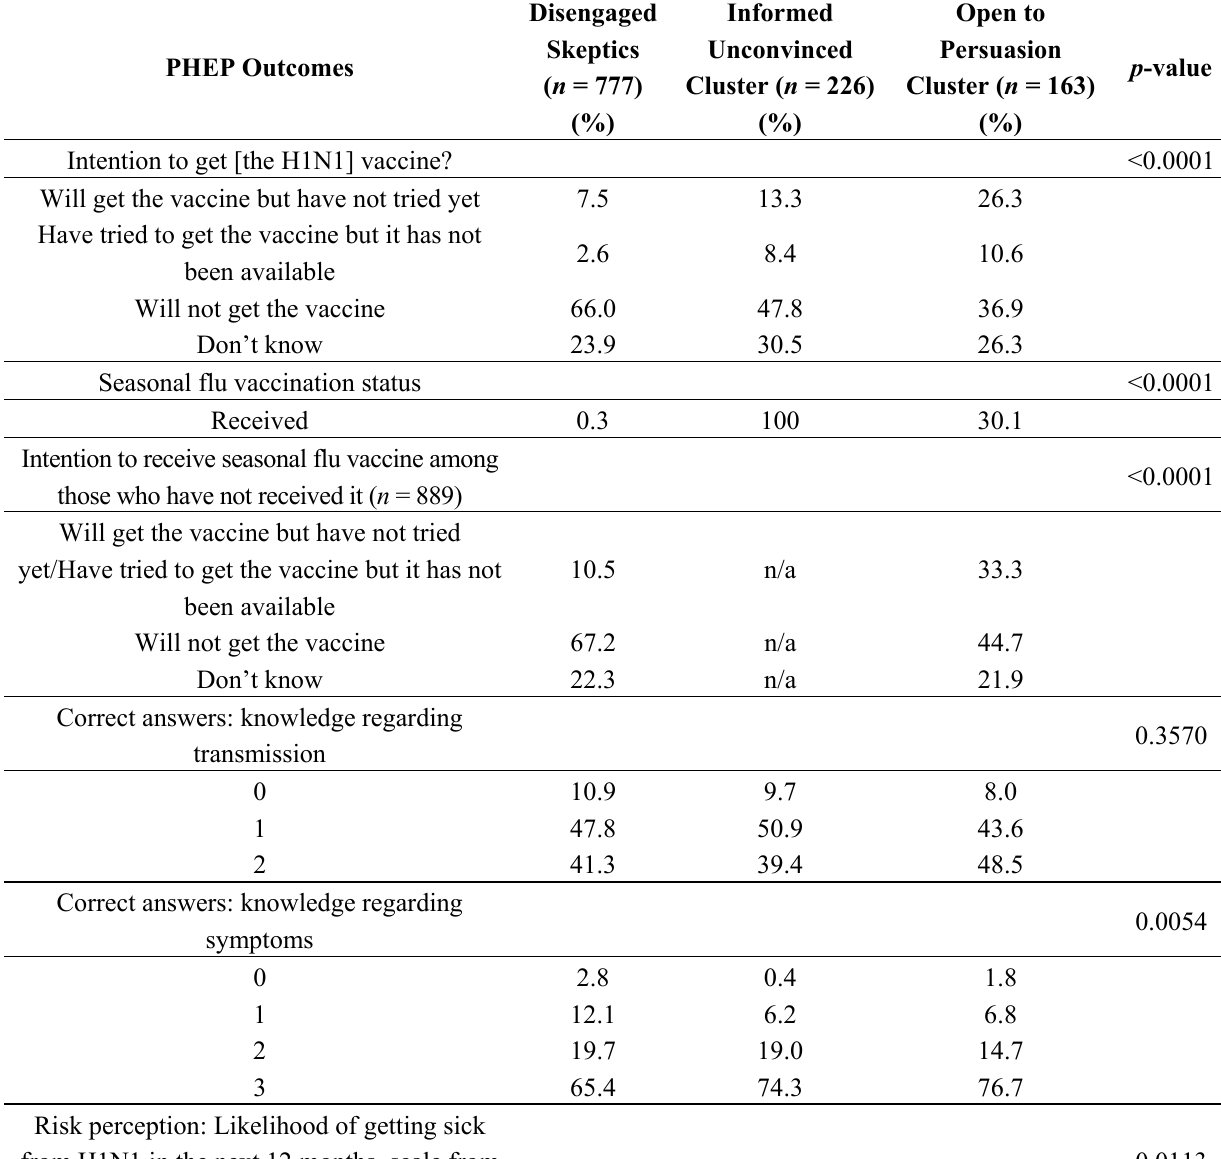
Table 2. Distribution of PHEP outcomes between the cluster groups ( n = 1166). PHEP Outcomes